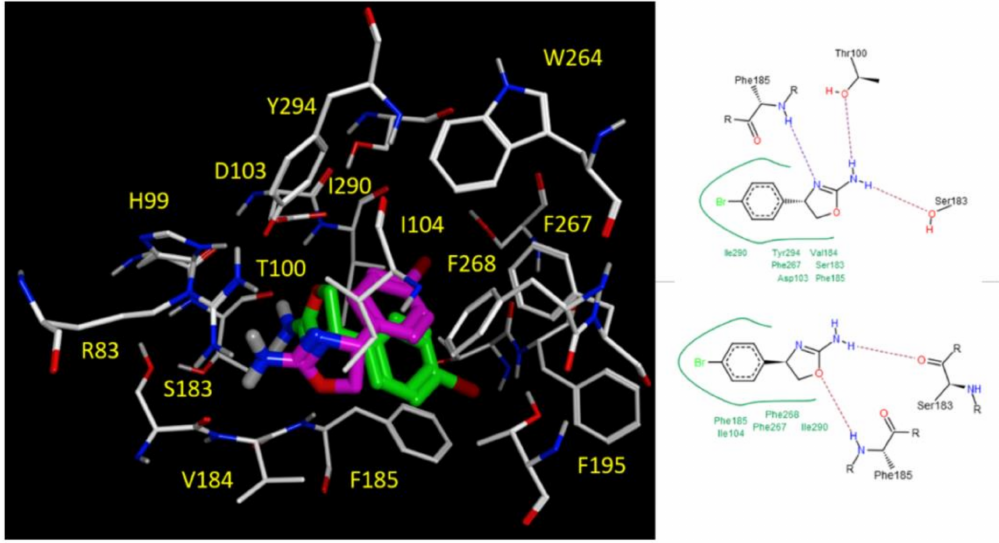
Figure 11. Docking positioning of the oxazolines 26b ( C atom; green) and 27b ( C atom; magenta) at the h TAAR1 putative binding site ( left ). Ligands are shown as sticks. The most relevant residues are labelled. A schematic perspective of the most relevant H-bonds experienced by the two agonists is also shown ( right